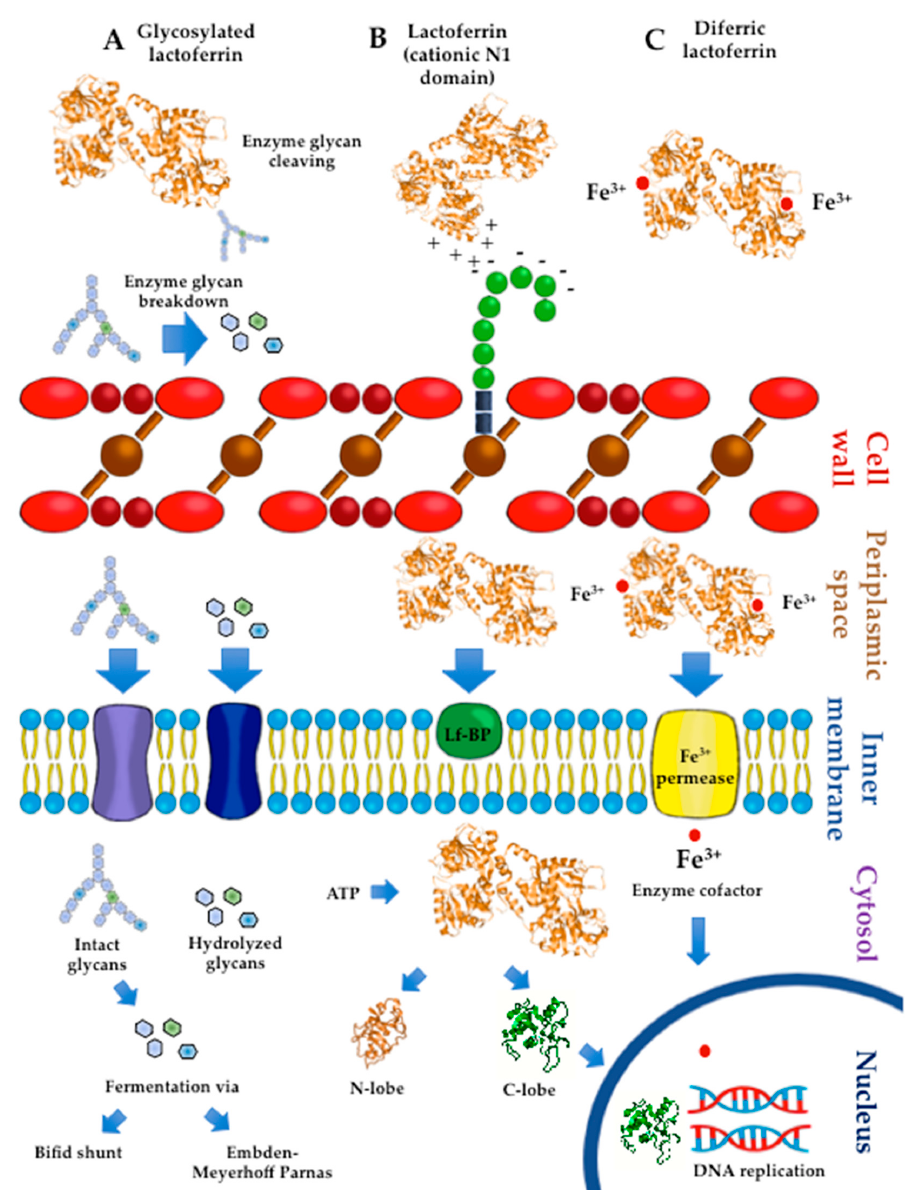
Figure 2. Simplified hypothetical mechanisms that may account for the in vitro growth-promoting effects of lactoferrin (Lf) on probiotics (bifidobacteria and lactobacilli). ( a ) Lf glycans undergo enzymatic hydrolysis to produce both intact oligosaccharides and the products of cleavage (disaccharides and monosaccharides). Intact and hydrolyzed glycans are transported via cell membrane permeases to the cytosol. In the cytosol, glycans are terminally hydrolyzed to yield monosaccharides used by cytosolic enzymes as substrates of fermentation via the Embden–Meyerhof–Parnas or bifid shunt pathways to produce energy for cell growth. ( b ) The cationic surface of Lf interacts electrostatically with acidic components of the cell wall that are negatively charged, such as teichoic acids. This interaction may favor the internalization of Lf in the periplasmic space and its eventual binding to cell membrane proteins for translocation to the cytosol. In the presence of ATP, Lf dissociates to the N-lobe and C-lobe. The latter is internalized in the nucleus and interacts with DNA to modulate genes involved in the mechanisms of DNA replication for cell growth. ( c ) Diferric Lf reaches the periplasmic space, where iron in ferric form is released and then translocated via a permease to cytosolic compartments. Ferric ions are considered an essential cofactor of enzymes involved in crucial processes of metabolism and DNA replication for growth. RasMol ™ 1994 by Roger Sayle © was used as the software for modeling and coloring the tertiary protein